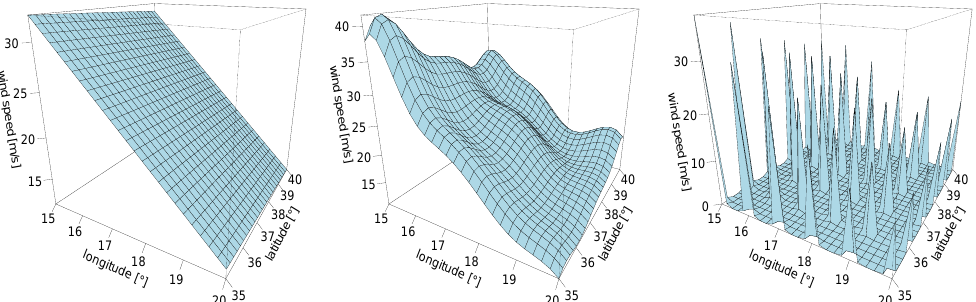
Figure 10. The RBF method interpolation surface with ε = ( 0.01,1,10 ) . When ε = 0.01, interpolation surface is flat ( left ), ε = 1 returns a satisfactory surface ( middle ), when ε = 10, surface will be noisy ( right